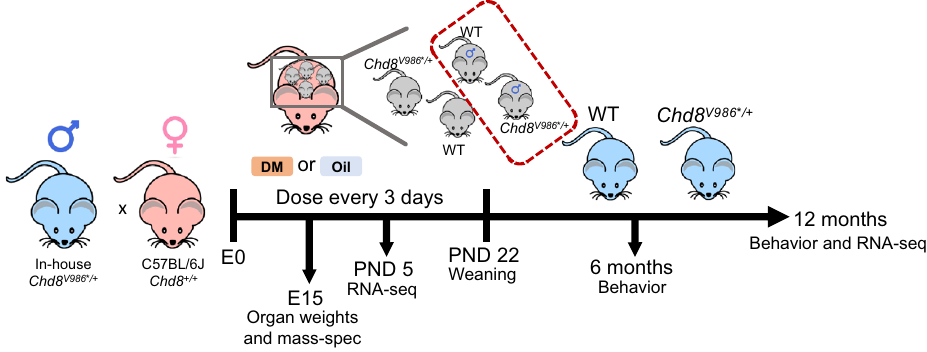
Figure 1. Experimental design. WT C57BL/6J females were bred with Chd8 V986*/ + males. The dam was administered 3 mg/kg of DM or oil mixed into peanut butter every 3 days, beginning at E0. At E15, organs were weighed and DM was measured with mass spectrometry. RNA-sequencing was performed at PND 5